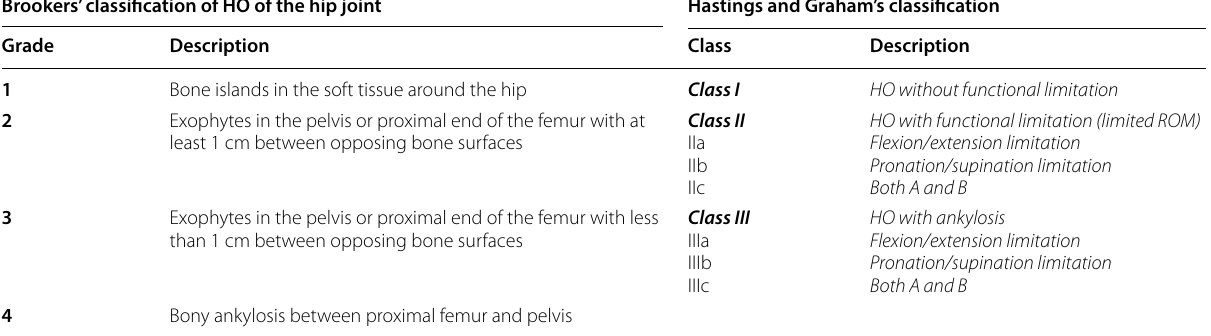
Table 1 Heterotopic ossification staging Brookers’ classification of HO of the hip